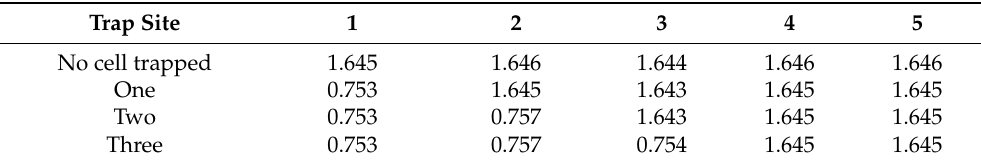
Figure 4. Simulations of flow velocity distributions of three − dimensional channels. ( A ) Flow velocity distributions before cell trapping. ( B ) Flow velocity distributions when one cell was trapped. ( C ) Flow velocity distributions when three cell capture sites were taken. ( D ) Three − dimensional channels used for the simulation, in which cells were assumed as solid spheres and took three capture sites. Table 1. Q ratio values of the five sites of the optimized model when zero, one, two and three cells were trapped,